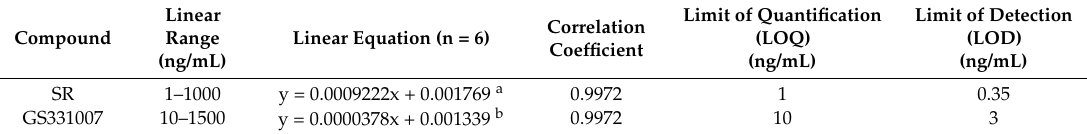
Table 1. The linearity and lower limit of quantification (LLOQ) of sofosbuvir and